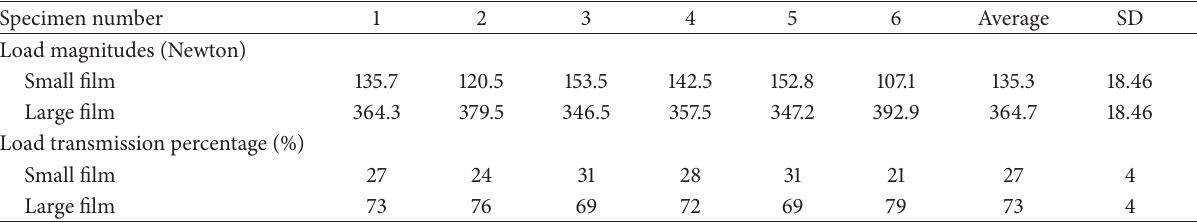
Table 2: Load absorbed by the films and load transmission percentages.